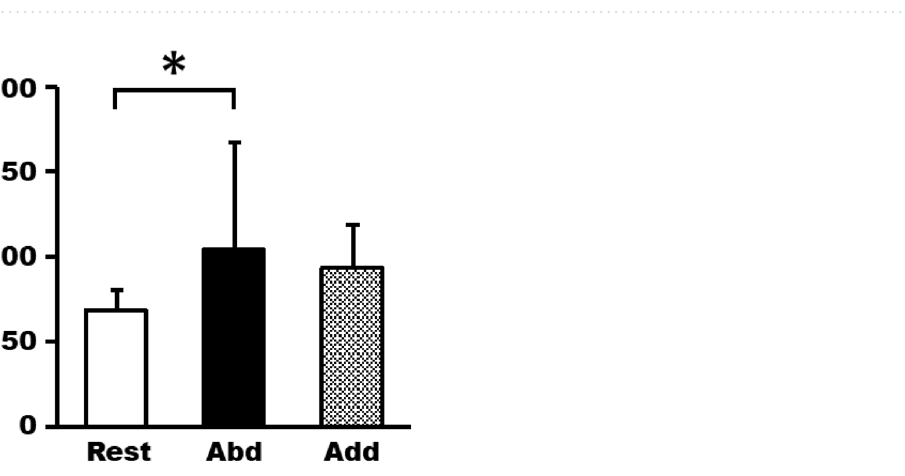
Figure 6. Average ± SD of the FDI MEP amplitude ( A ) and background EMG activity ( B ) during ME of three phases. ( ** p < 0.01).